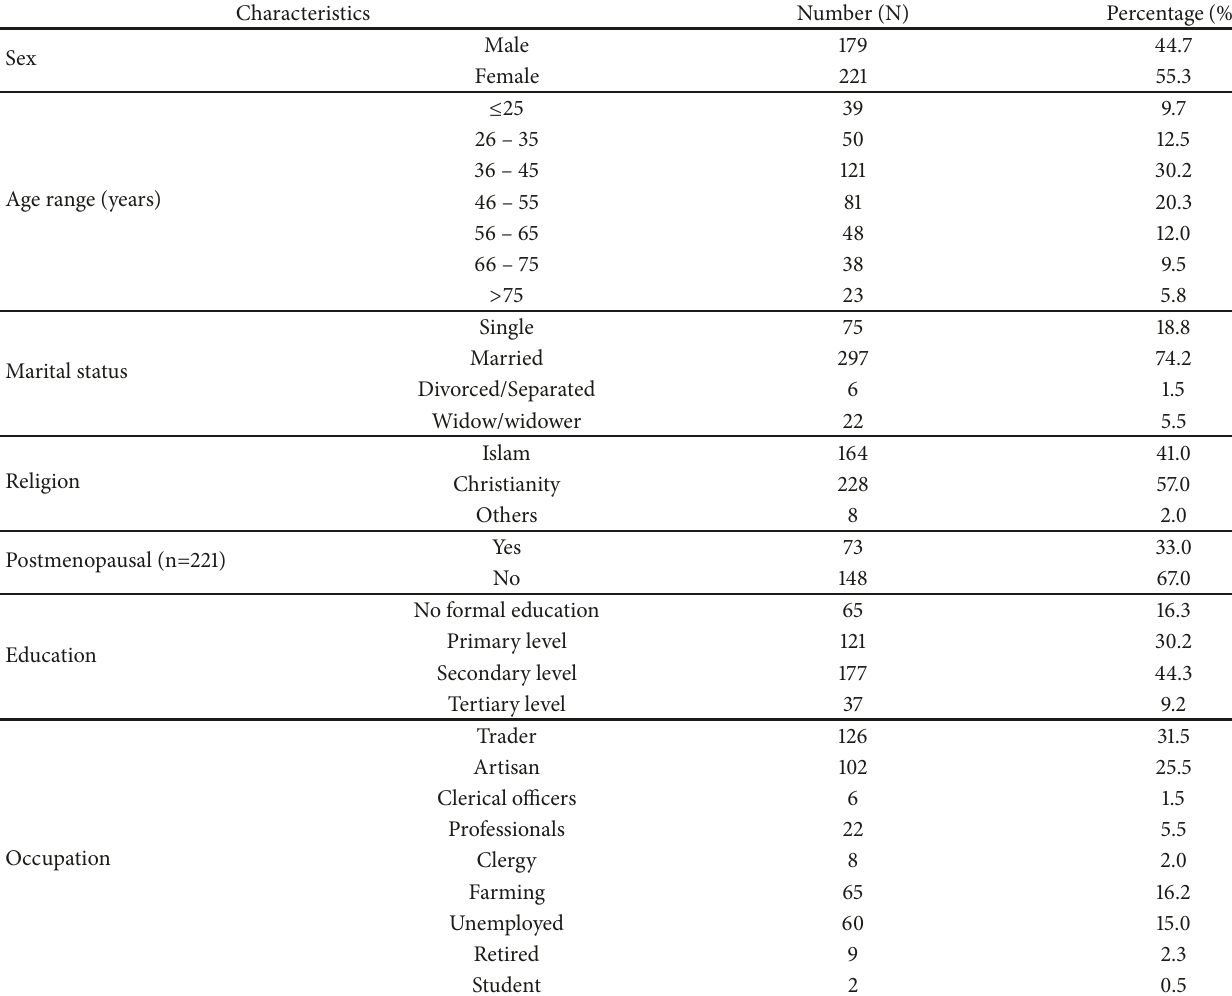
Table 1: Sociodemographic characteristics of the subjects.